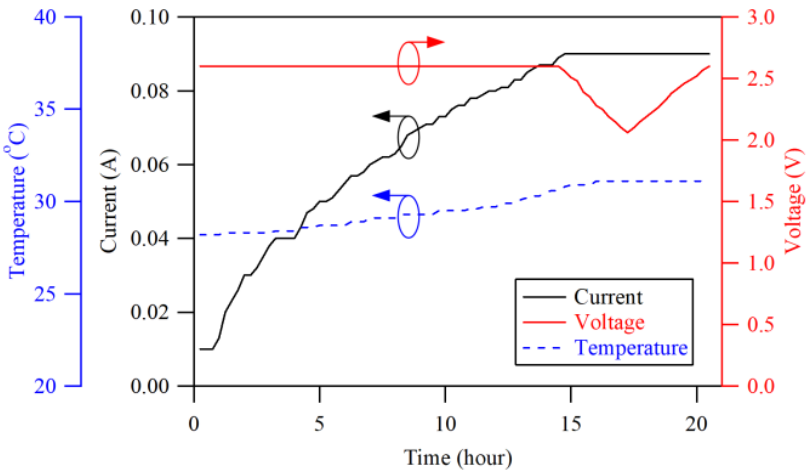
Figure 10. Charging response of the recovered cell (charged at 2.6 V).